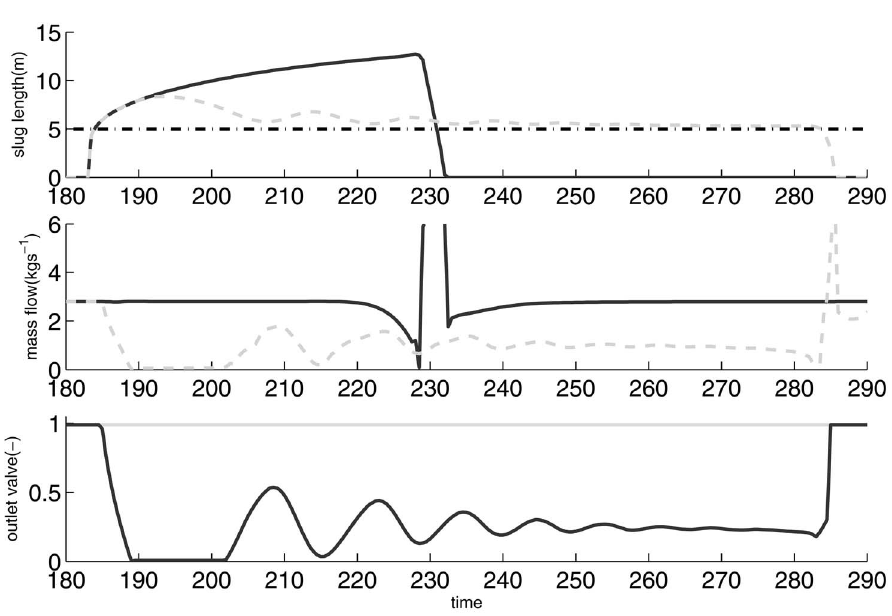
Figure 3. Active control using the outlet choke: A growing slug (solid) compared with a slug controlled by (1) (dashed) toward a reference length